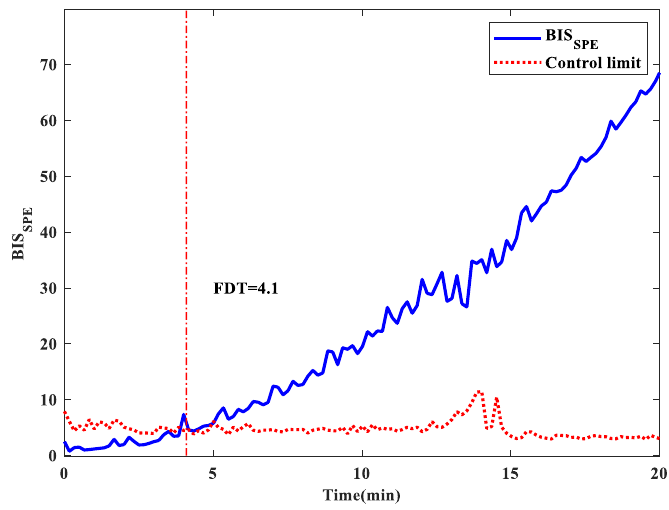
Figure 11. SPE fault monitoring chart of F5 based on NMI-WMPCA.